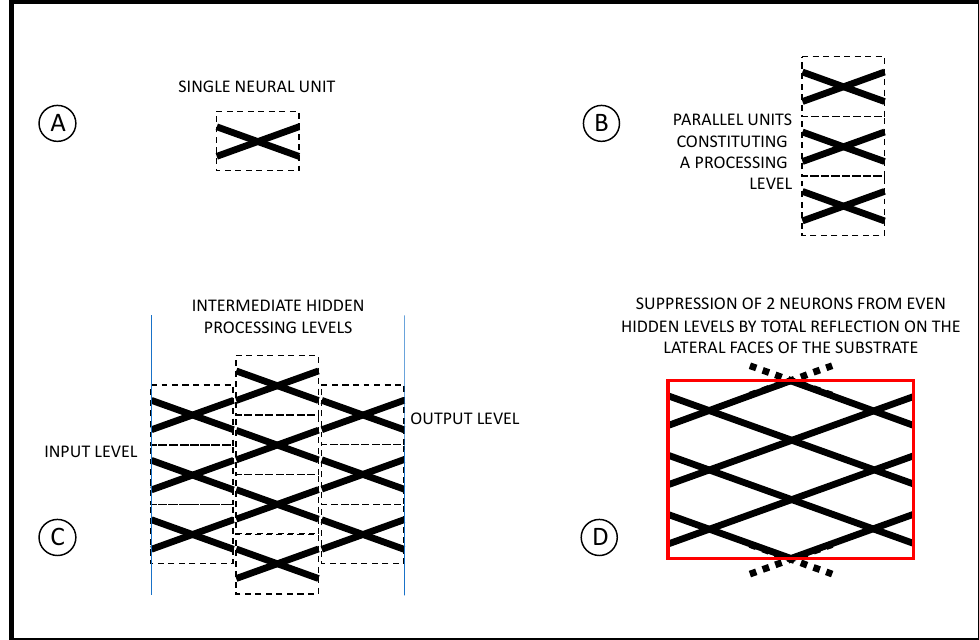
Figure 2. Schematic architecture of an SNN used for bit-to-bit storage of information. ( A ) A single neural unit structure is constituted by a single X-junction; ( B ) one processing level in the network consists of several units in parallel; ( C ) successive levels of the network are connected in series with each other; ( D ) even-order levels have two fewer units. The suppression of these units is replaced with the insertion of the total reflections at the lateral edges of the substrate.